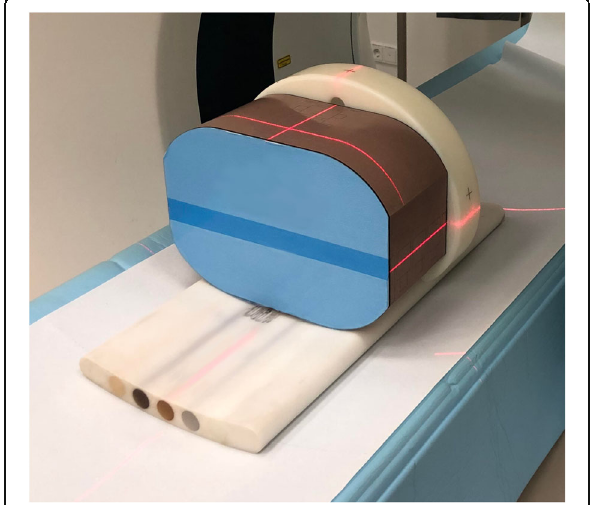
Fig. 1 Illustration of the European spine phantom (blue, brown) (ESP-040; QRM GmbH, Moehrendorf, Germany) and the QCT bone density calibration phantom (white, below) (BDC-03-29; QRM GmbH, Moehrendorf, Germany). Labels of the manufacturers have been removed. QCT, Quantitative computed